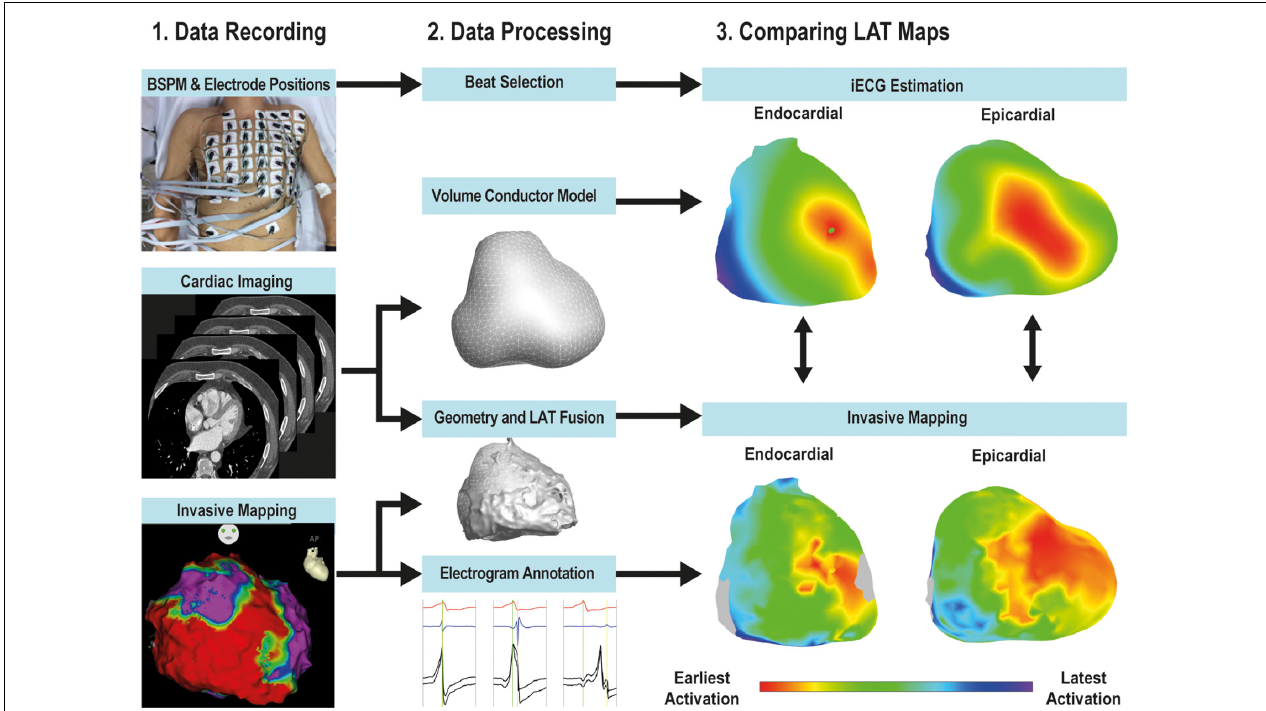
FIGURE 1 | Workflow. The workflow of the study consisted of data recording (left panel), data processing (middle panel) and quantitative comparison (right panel). Body surface potential mapping (BSPM) using 67-electrodes was performed. CT imaging of the thorax and cardiac anatomy was performed and used to construct patient specific anatomical models and compute the volume conductor. The EAM anatomical point clouds were registered to the CT-based ventricular anatomy and LAT and bipolar values were projected on the CT-based anatomy. EAM-LAT maps were quantitatively compared to i ECG-LAT